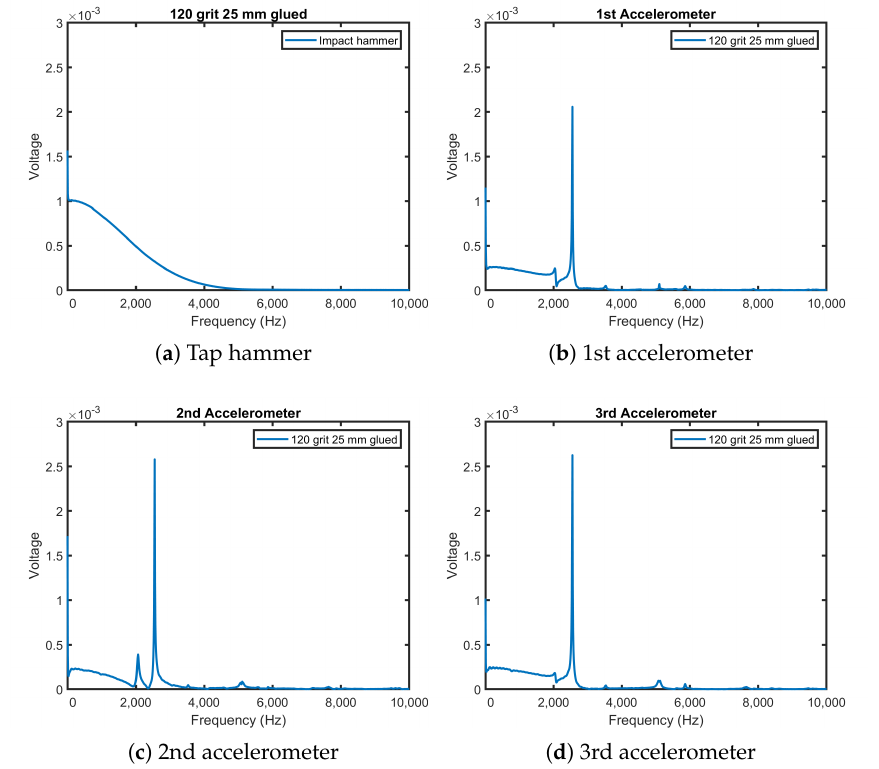
Figure 18. Typical natural frequency result of the 25 mm glued 120 grit